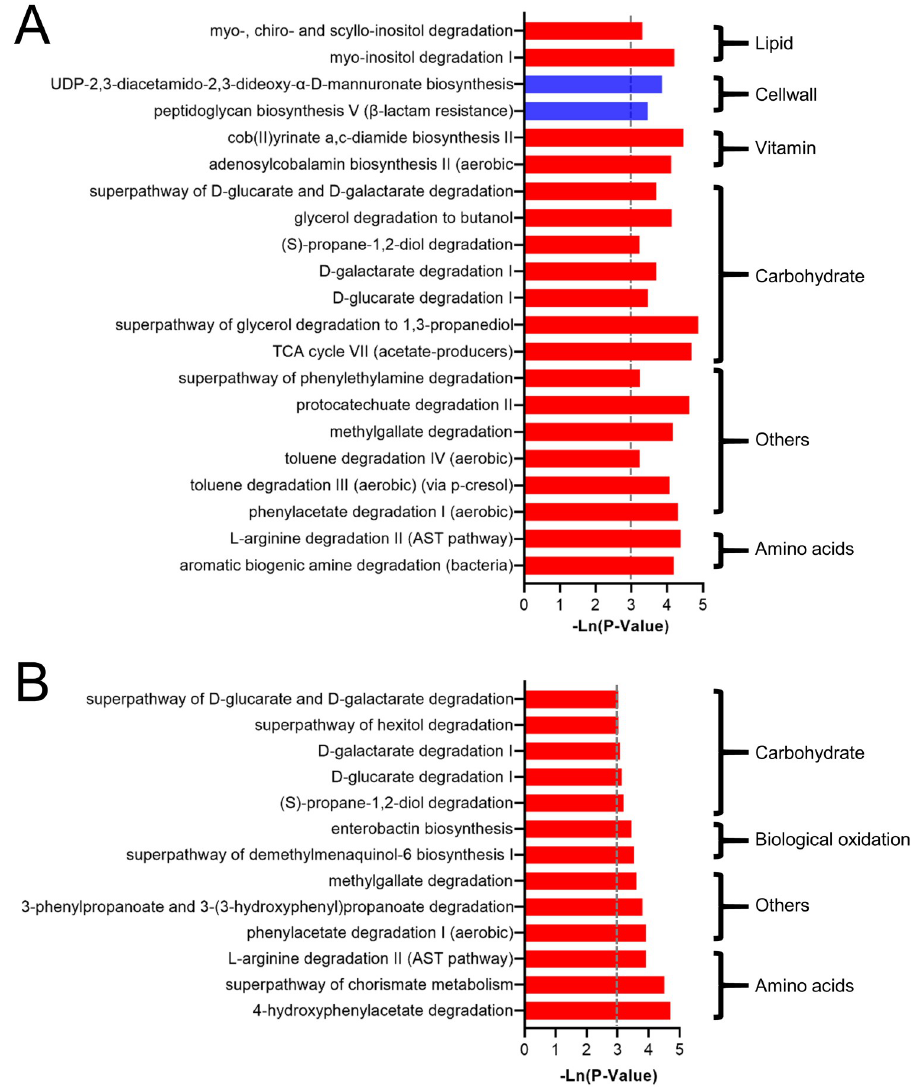
Fig 4. The effect of cat ownership on the composition of the microbiota of female and male individuals. The significant effect of cat ownership on microbial metabolism pathways in (A) female and (B) male individuals.